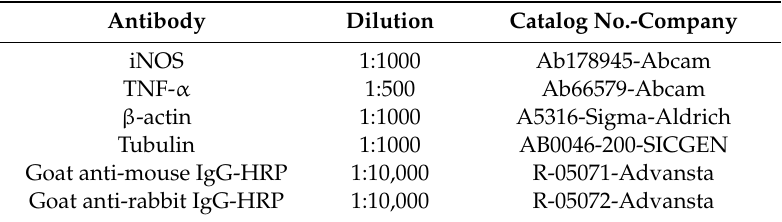
Table 2. Primary and secondary antibodies used for Western Blotting analysis. Antibody